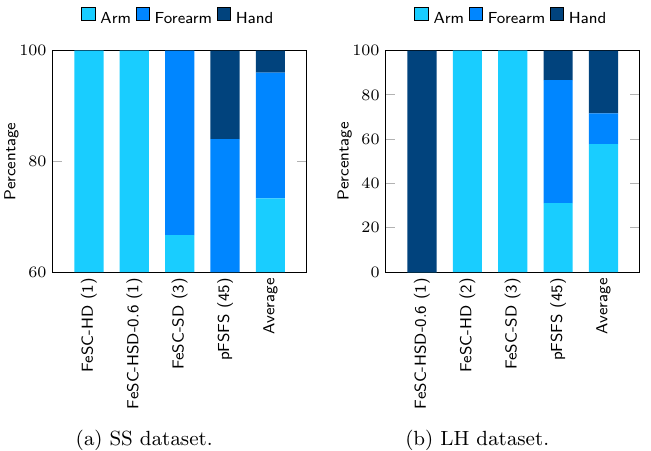
Fig. 4 Percentage of iterations in which each EMG feature was selected as stable by the different algorithms (threshold was set to 70%). To note, algorithms were sorted by the increasing number of stable